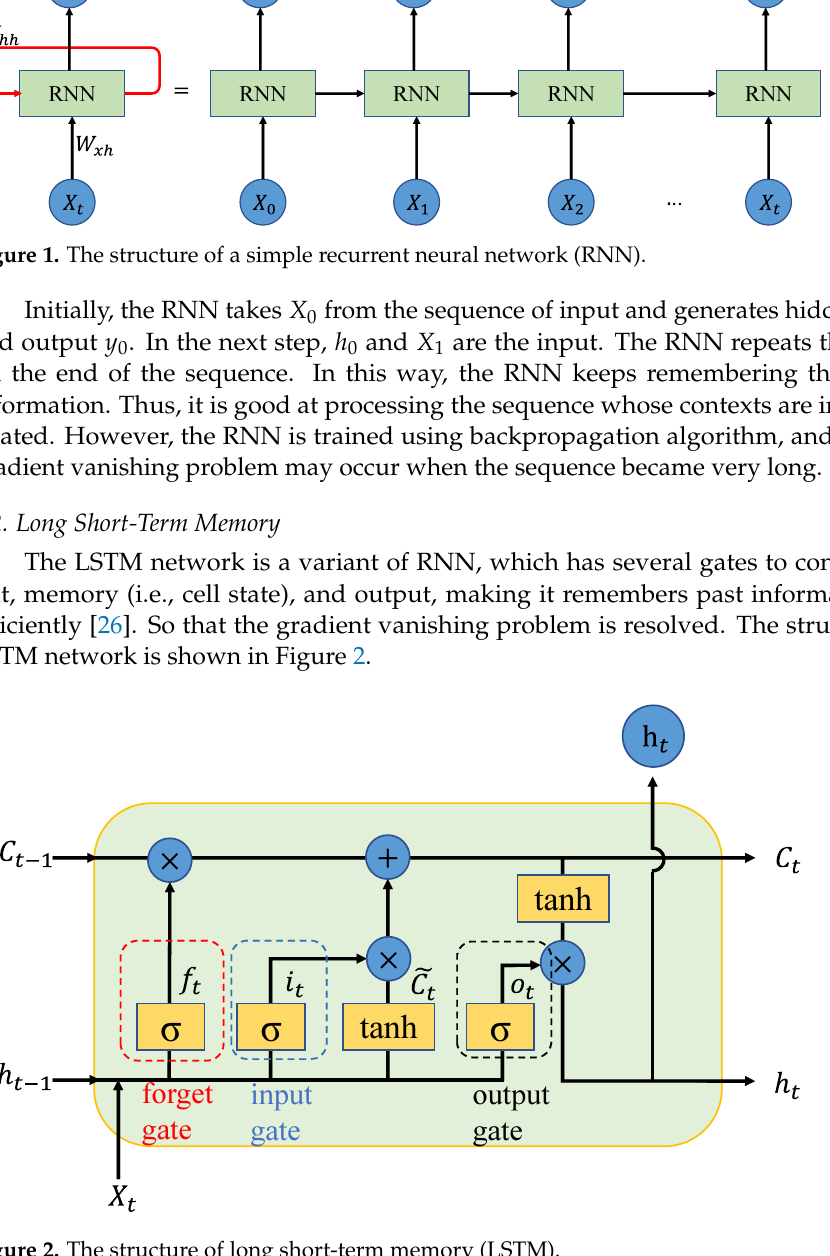
Figure 2. The structure of long short-term memory